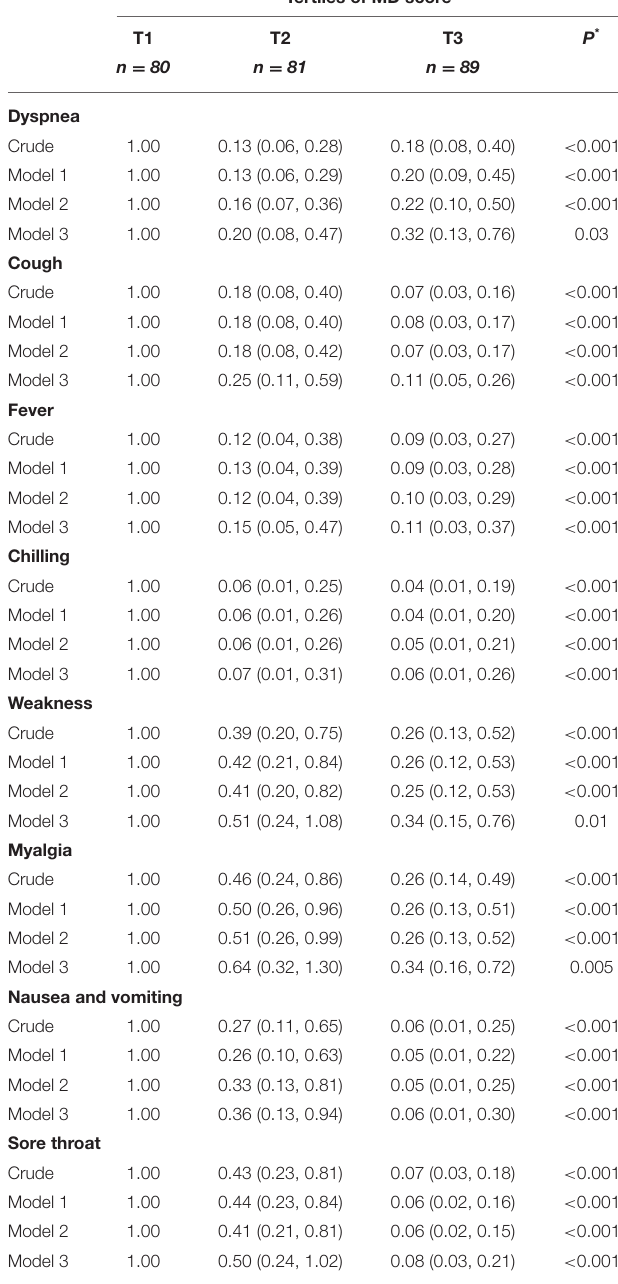
TABLE 5 | Odds ratio (95% CI) for symptoms of COVID-19 according to tertiles of Mediterranean diet. Tertiles of MD